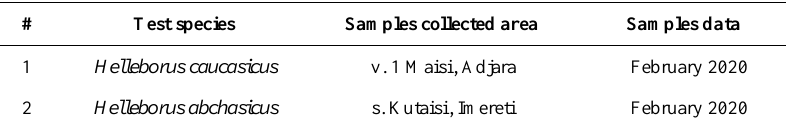
Table 1. Information about test samples